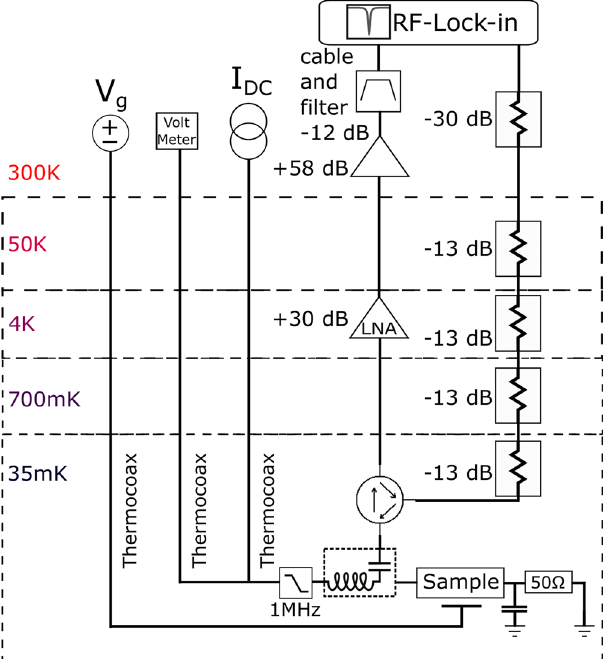
Figure 2. Schematics of the measurement setup. The audio (left half) and microwave (right half) circuitry is connected via a bias-T positioned between the sample and the circulator working over the band 600–900 MHz (Pamtech UTE1255K). The employed low noise amplifier was Caltech CITLF3. For details, see